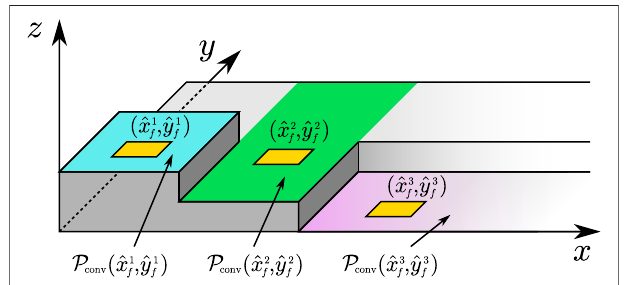
FIGURE 7 | A visual representation of the convex regions used in the ground patch